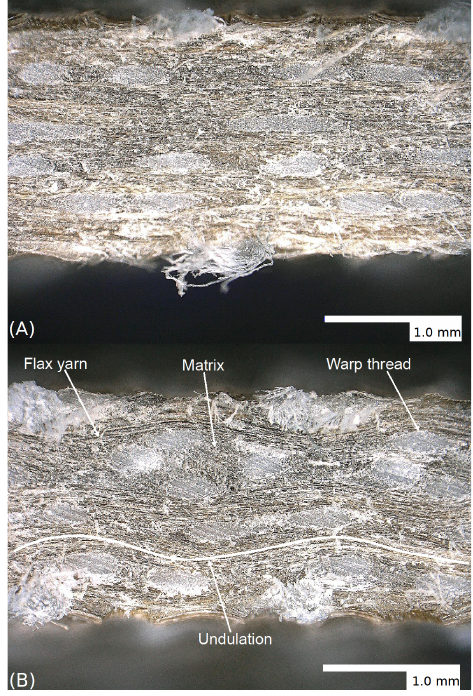
Figure 10. Micrographs (Keyence digital microscope VHX 6000, Osaka, Japan) of (A) composite laminates manufactured from the Lincore fabric and (B) a flax fabric (yarn V9) in a longitudinal direction. Table 6. Comparison of manufactured composites’ tensile properties with other high-performance flax fibre-reinforced epoxy resins described in the literature.